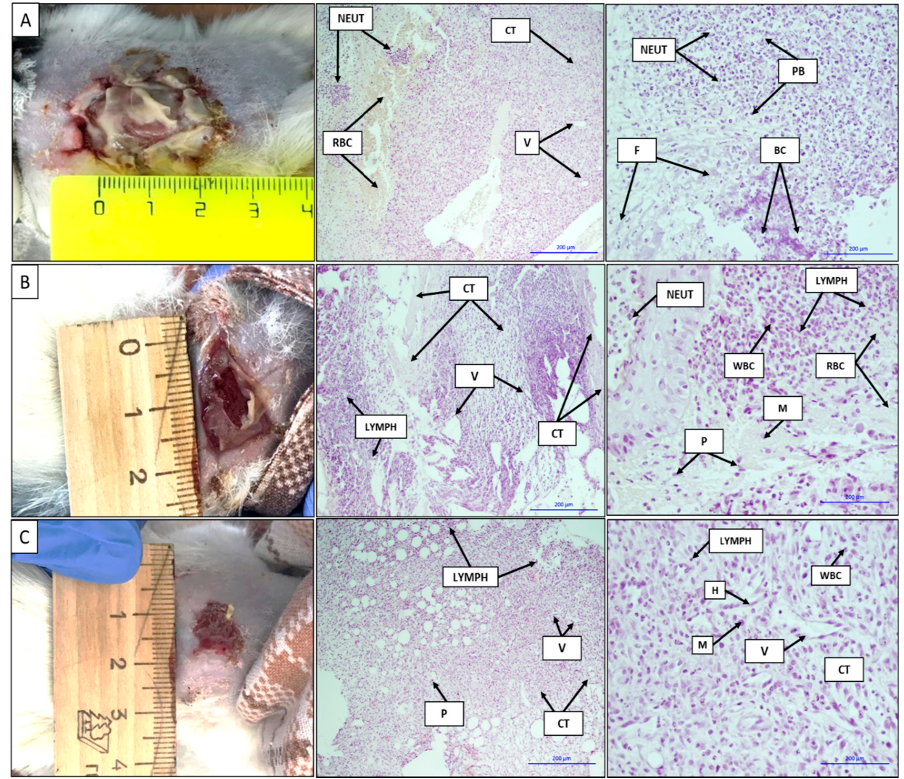
Figure 6. Images and histological sections of the contaminated full-thickness wound ( A ), the wound treated with a gauze dressing soaked in a chlorhexidine solution ( B ), and the wound treated with the VDF–TeFE membrane containing 15 wt % PVP on the 7th day ( C ). V: vessels, H: histiocytes, NEUT: neutrophils, WBC: leukocytes, RBC: erythrocytes, CT: connective tissue, LYMPH: lymphocytes, M: macrophages, P: plasma cells, F: fibrin, purulent bodies (PB): purulent bodies, bacterial colonies (BC): colonies of bacteria. The bars correspond to 200 µ